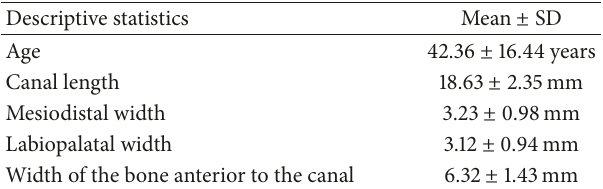
Table 1: Demographic variables and descriptive statistics of 79